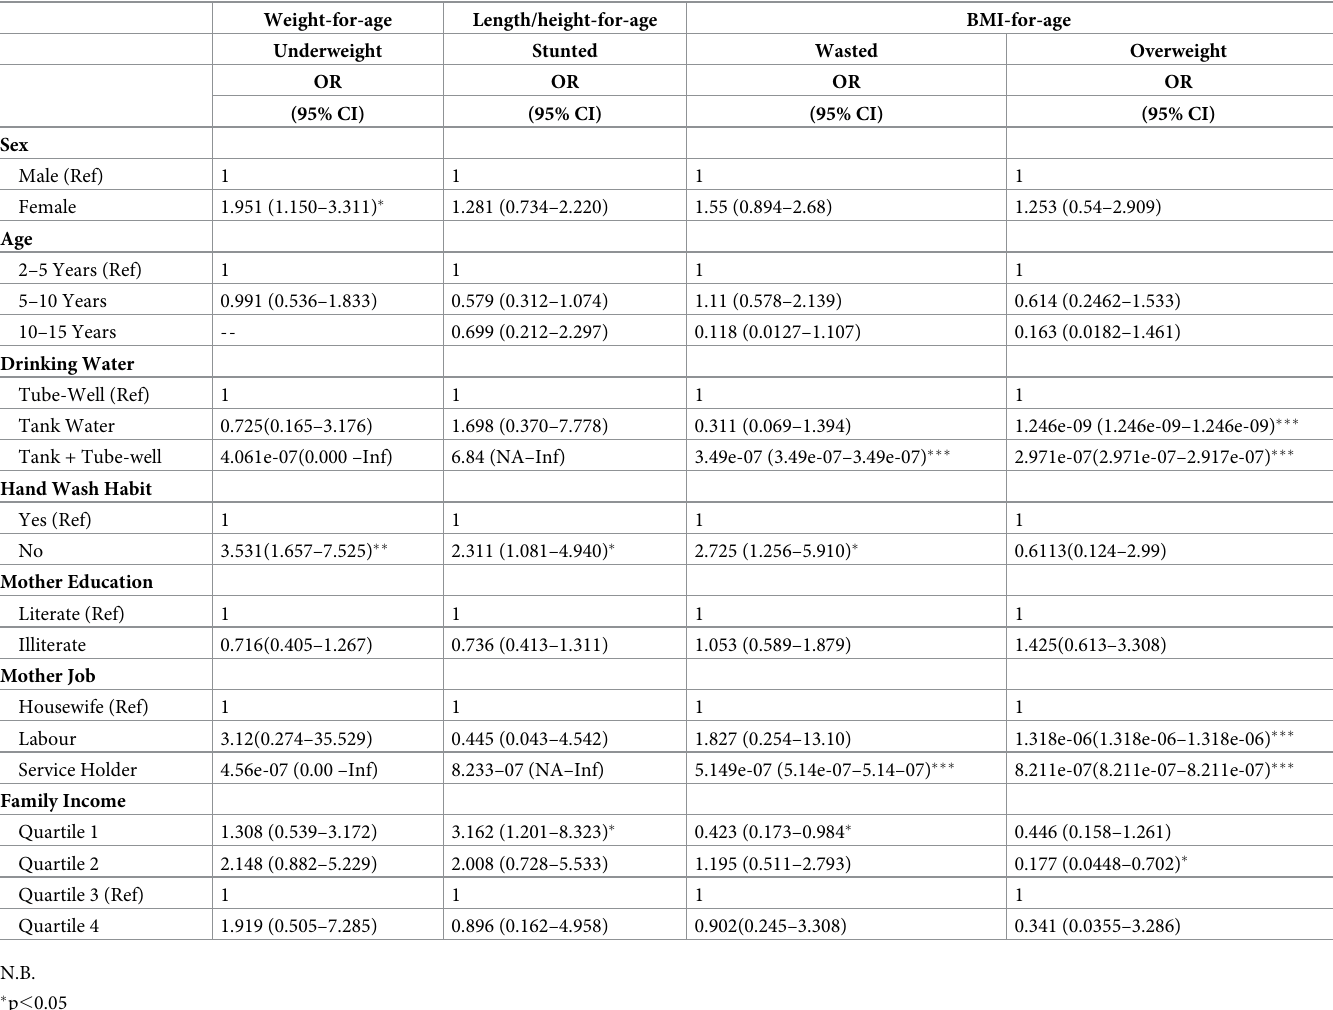
Table 5. Factors associated with malnutrition in using multivariate binary and polynomial logistic regression